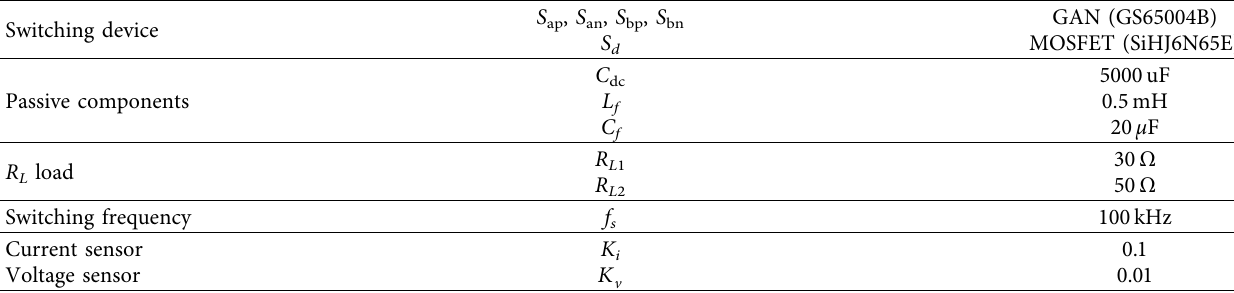
Table 2: Te specifcations for the experimental